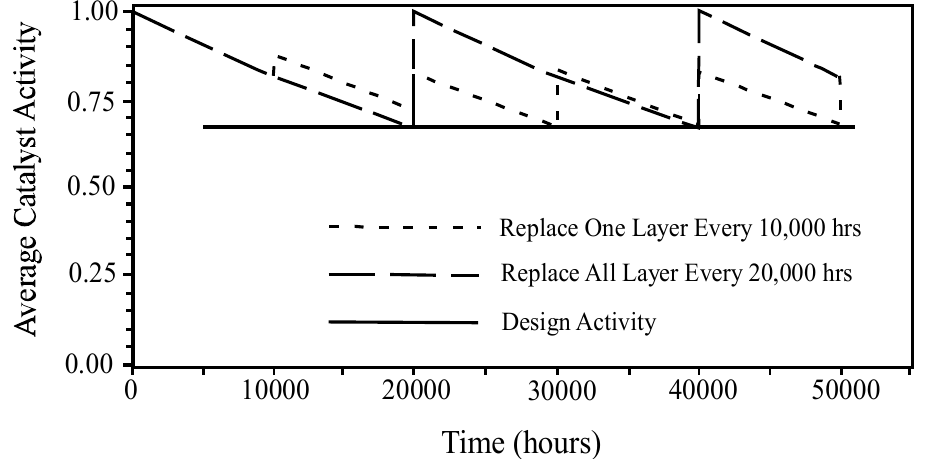
Figure 42. SCR replacement strategies: comparison of total replacement on a 20,000 h cycle relative to sequential replacement on a 10,000 h cycle while maintaining constant catalyst volume. Reproduced from